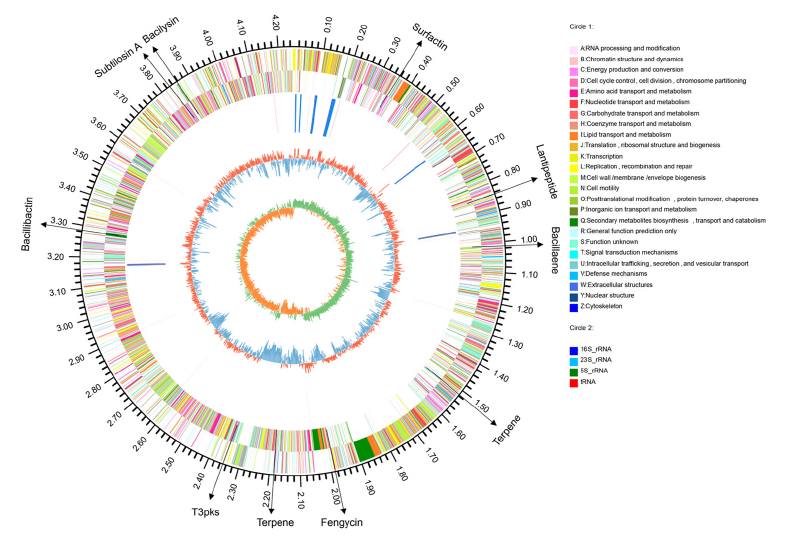
Figure 2. The whole-genome map of B. halotolerans KKD1. The genome map consists of seven different circles. From the inner circle to the outer circle: (1) GC skew. (2) G + C content. (3) The locations of the secondary metabolite clusters. (4) Reverse COG function classification. (5) Forward COG function classification. (6) Reverse CDS. (7) Forward CDS. Comparison of B. halotolerans KKD1 with the model strains B. velezensis FZB42 and B. subtilis 168 revealed that the three genomes had 3122 core genes in common, but 588 genes were unique to B. halotolerans KKD1 (Figure 3A). Structural genome analysis with the Mummer software revealed that B. halotolerans KKD1 and B. subtilis 168 share a conserved genomic structure and homologous gene composition, but some inversion events also oc- curred in the genome of these two strains during evolution (Figure 3B–D). On the con- trary, B. halotolerans KKD1 and B. velezensis FZB42 showed a less conserved genomic struc- ture and homologous gene composition (Figure 3E,F).